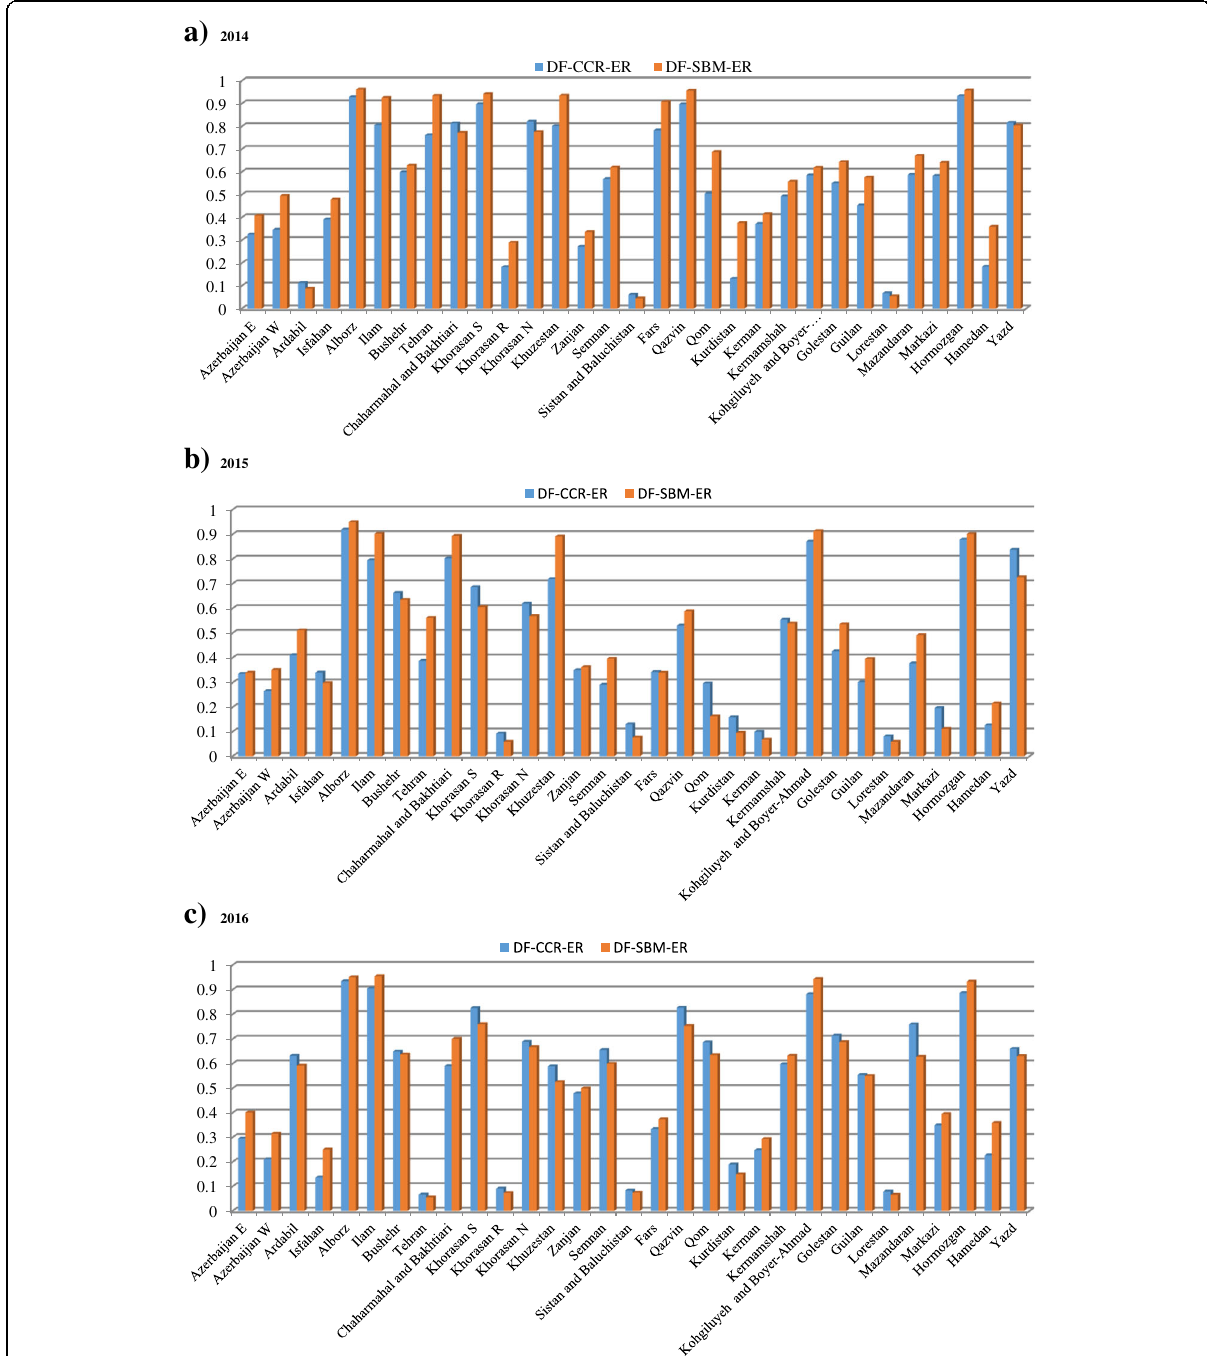
Fig. 4 Comparisons between the efficiency results obtained using DF-CCR-ER and DF-SBM-ER [15]